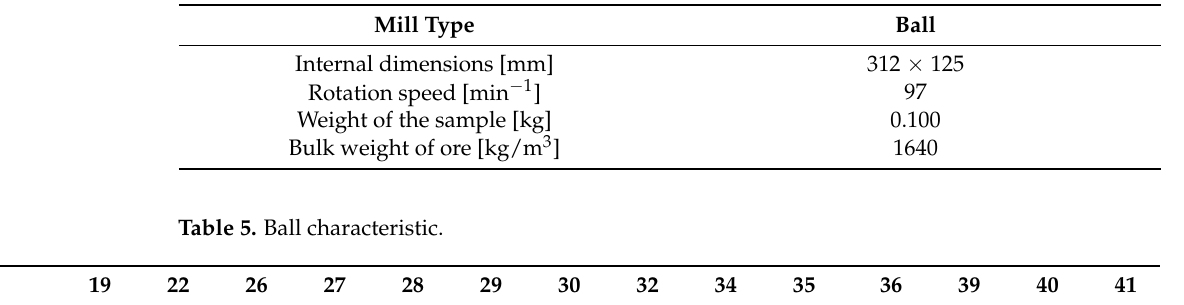
Figure 4. Upgraded mill for exhaust of generated gases. Table 4. Comminution conditions.